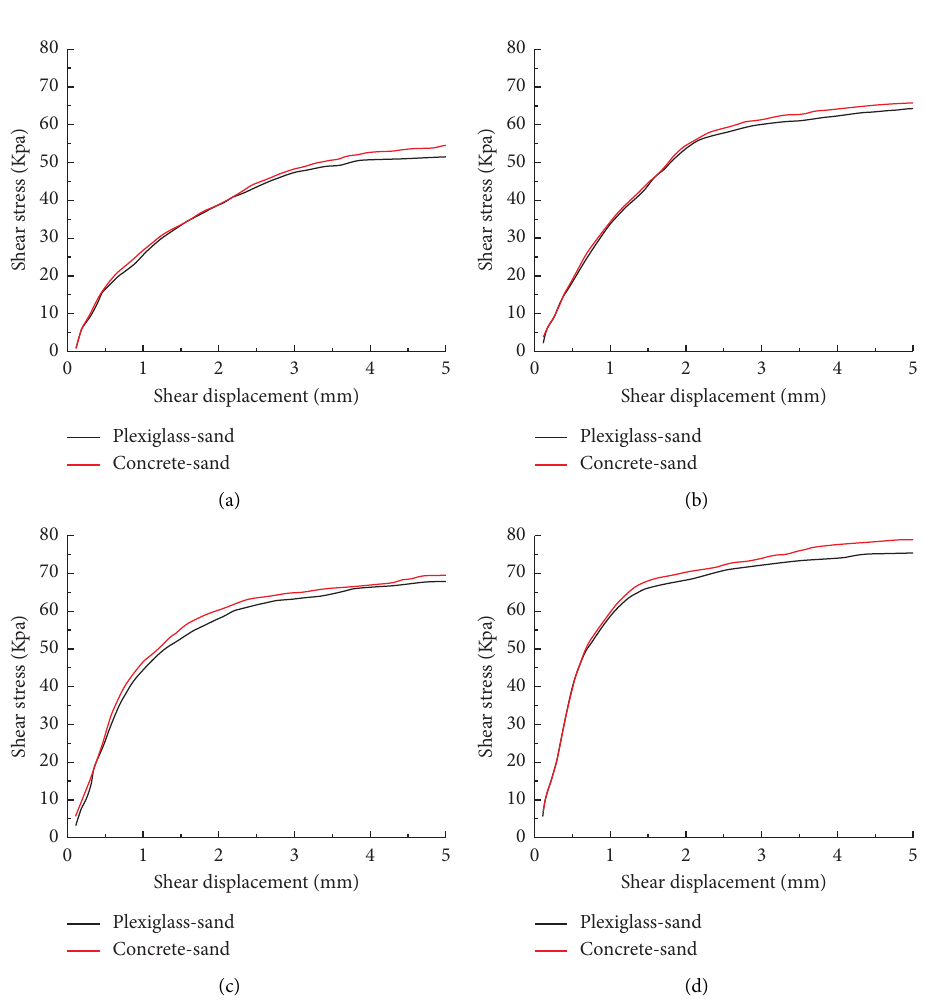
Figure 4: Direct shear test curves of the plexiglass-sand